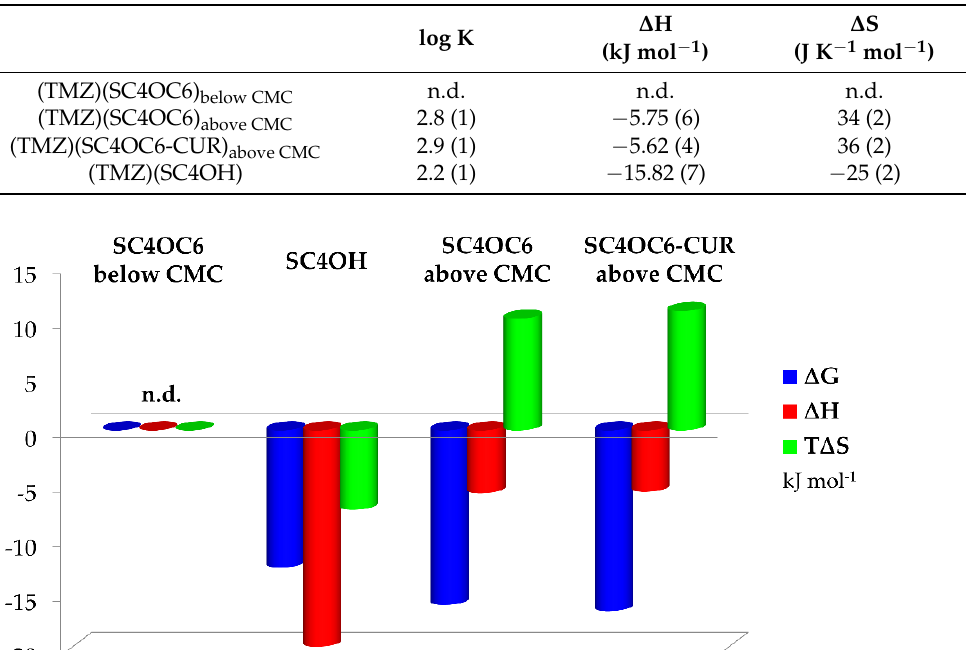
Table 1. LogK values and thermodynamic parameters for the interaction of TMZ with calixarene- based receptors in their monomeric or aggregated form at 25 ◦ C in neutral aqueous buffered solution. log K